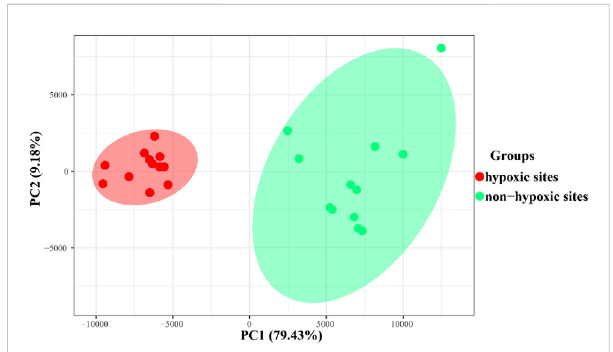
FIGURE 5 PCoA plot showing the archaeal similarities within the hypoxic and non-hypoxic zones and dissimilarities between zones based on Bray-Curtis distances.